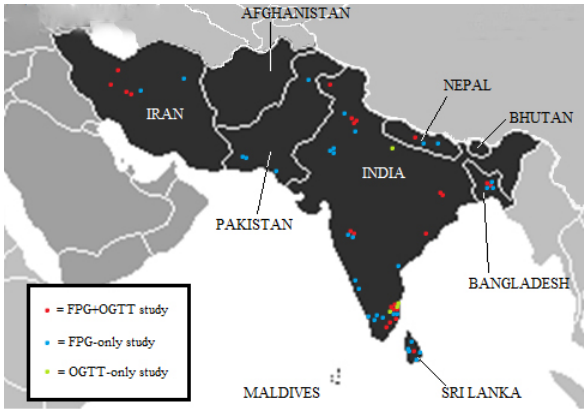
Figure 2. Approximate geographic locations of the study cohorts. FPG –fasting plasma glucose, OGTT –oral glucose tolerance